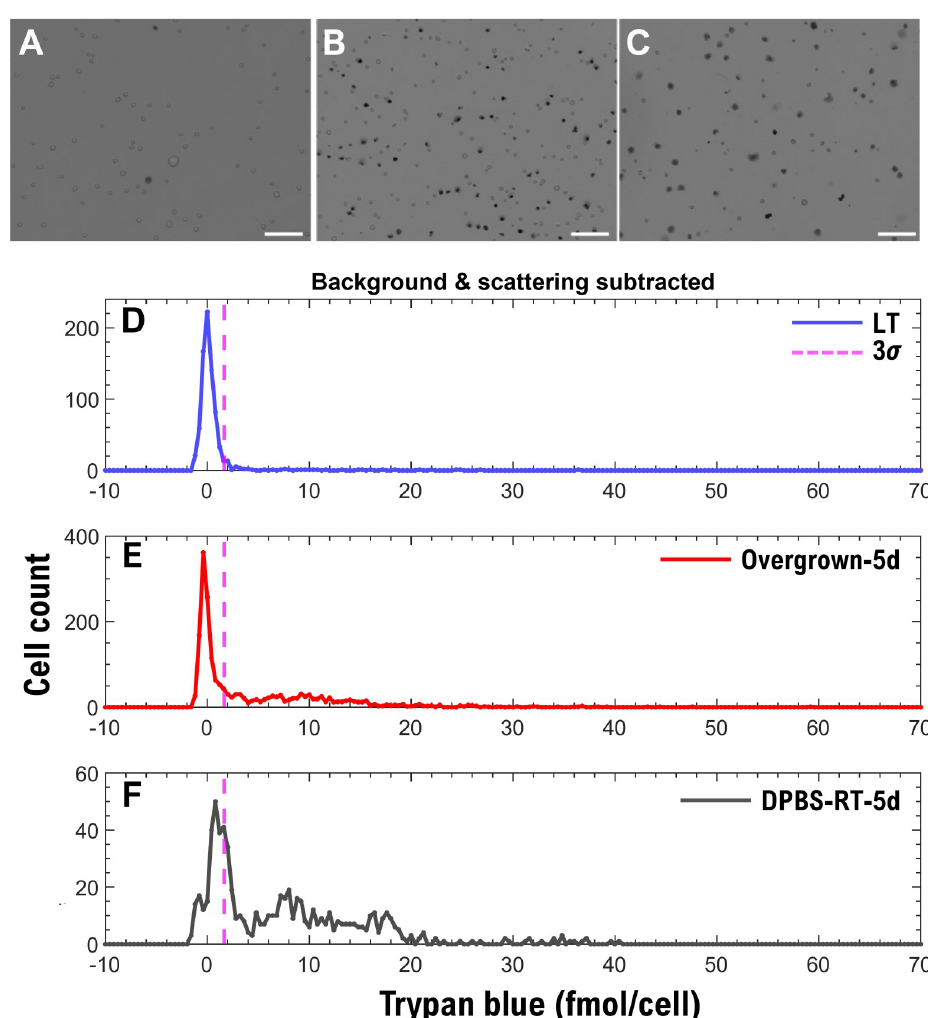
Fig 9. Intracellular trypan blue (TB) content (mol/cell) for cells overgrown for five days and cells incubated in DPBS at room temperature for five days. Brightfield images of (A) LT, (B) ‘Overgrown-5d’ and (C) ‘DPBS-RT-5d’ samples. Absorbance microscopy histograms for (D) LT, (E) ‘Overgrown-5d’ and (F) ‘DPBS-RT-5d’ samples indicate the TB uptake by Jurkat cells (the background TB and scattering are subtracted). Abbreviations: LT = live cells in trypan blue (TB) solution mixed with Dulbecco’s phosphate-buffered saline (DPBS) at a 1:4 (TB:DPBS) ratio. The dashed purple line marks three standard deviations (3 σ ) for the Gaussian fit of the histogram in panel (D) , which serves as a threshold point for counting dead cells in panels (E) and (F) . Scale bars: 100 μ m. different microscopes, TB-stained heat-shock killed cells (LT) had a 21.9% difference in TB molarity but only a 3.8% difference in mol/cell (Fig 7). The difference between the TB molarity for the heat-shock killed cells on Microscope 1 versus Microscope 2 could be caused by the cell volume measurements. For the heat-shock experiments, the mean cell volume was 1.39 ± 0.18 pL (n = 3 replicates, same sample preparation, data acquired on three different days) for Microscope 1 and 1.80 ± 0.28 pL (n = 3 replicates) for Microscope 2, which is a difference of 22.8% (S6 Fig). Since molarity is equal to moles/volume, a 22.8% difference in volume nearly accounts for the 21.9% difference in TB molarity. The cause of the volume differences is unknown. There may have been actual differences in cell volume between the experiments possibly caused by differences in passage number or minor variations in culture conditions.